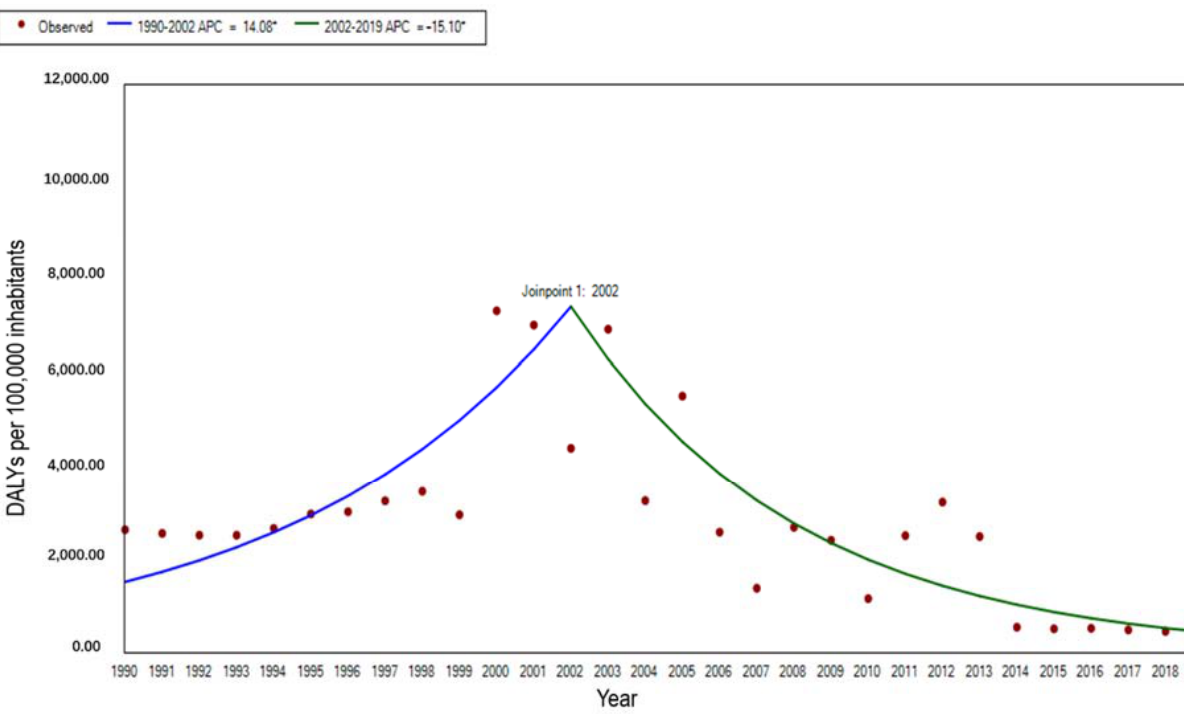
Figure 3. The trend of age-standardized DALY rate for malaria in STP, 1990–2019. Note: * indicates p < 0.05.